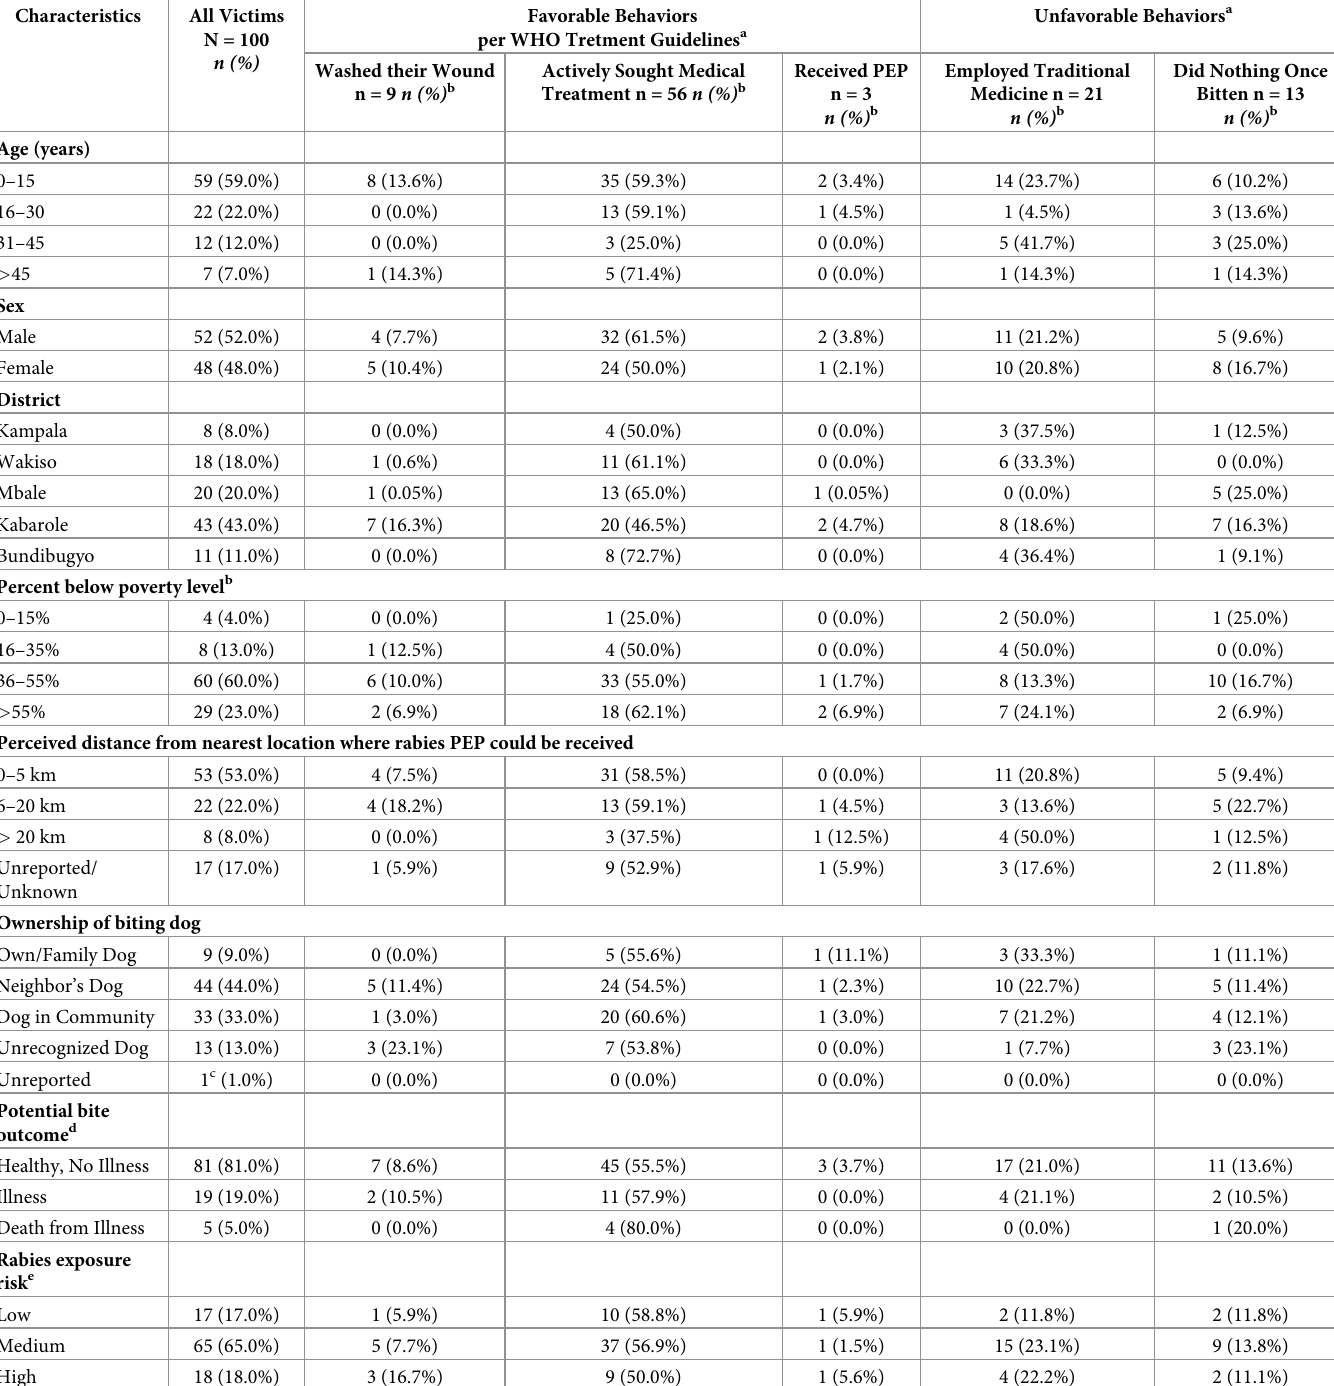
Table 6. Characteristics and healthcare-seeking behaviors of 100 canine-bite victims among the 798 surveyed households, Uganda, 2013.